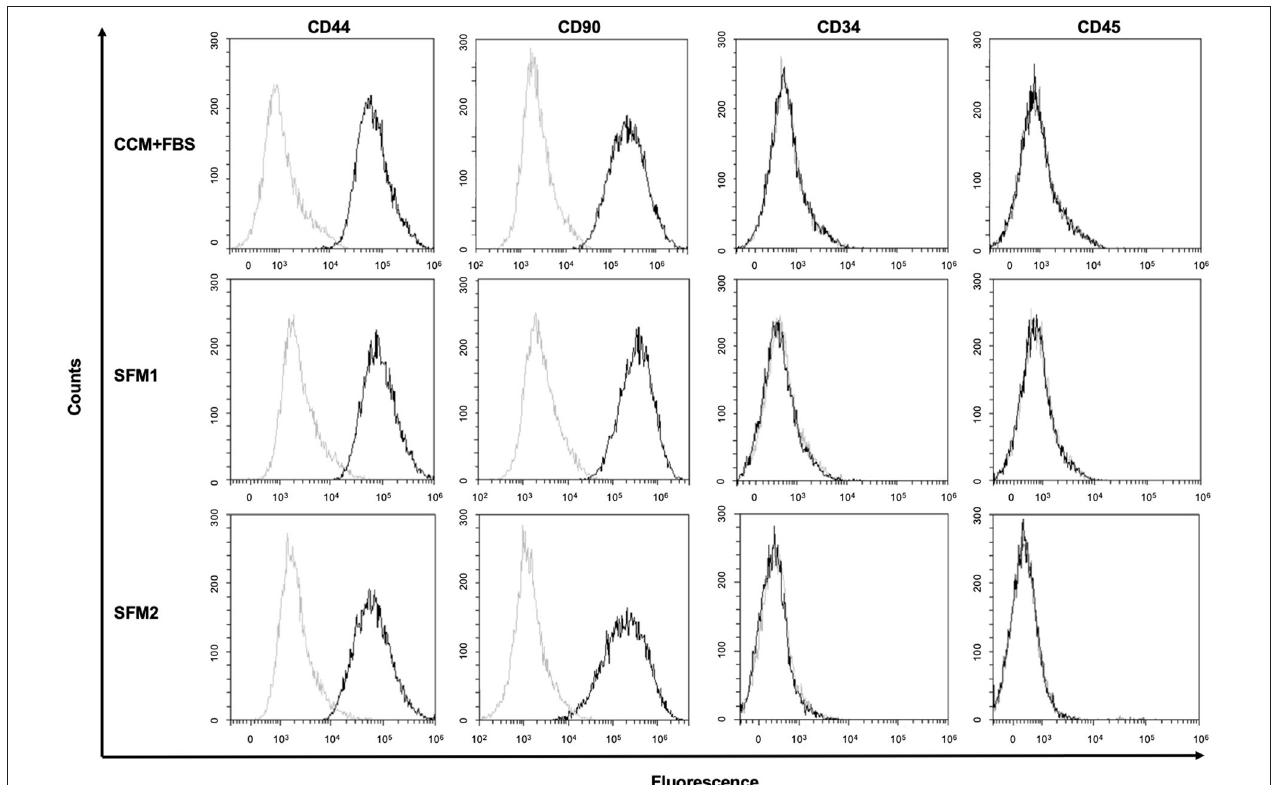
FIGURE 3 | Surface marker of canine MSCs. Representative results of flow cytometric analysis of canine MSCs derived from CCM + FBS, SFM 1 and SFM 2 (black line). Isotype controls are shown in each panel (gray line).